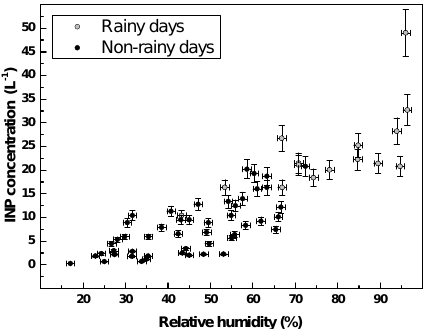
Figure 3. Data of INP concentrations at different ambient relative humidity levels.